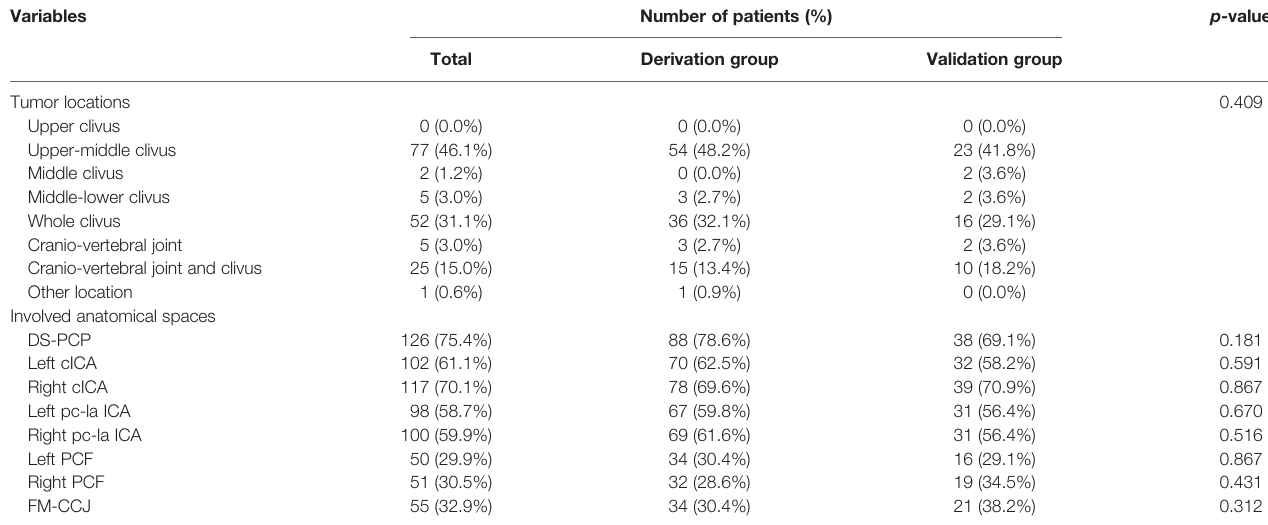
TABLE 2 | The detailed tumor locations and involved anatomical